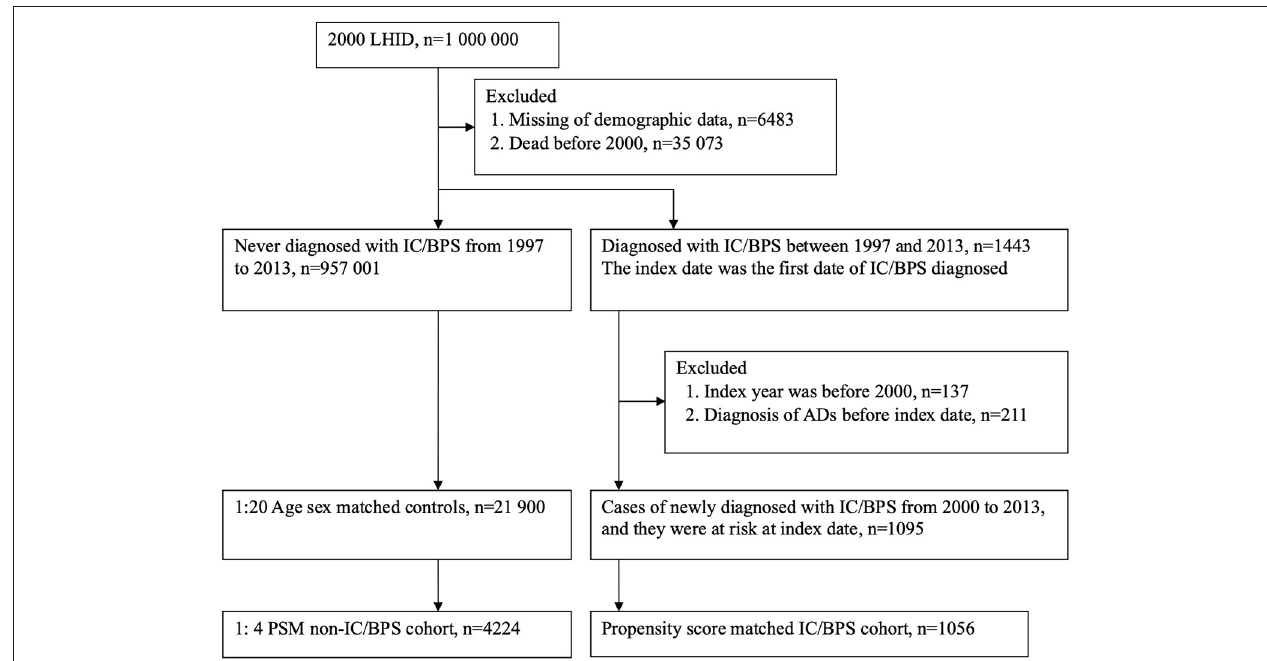
FIGURE 1 | Study flow chart for population selection. LHID, Longitudinal Health Insurance Datasets; IC/BPS, interstitial cystitis/bladder pain syndrome; ADs, autoimmune diseases; PSM, propensity score matching.